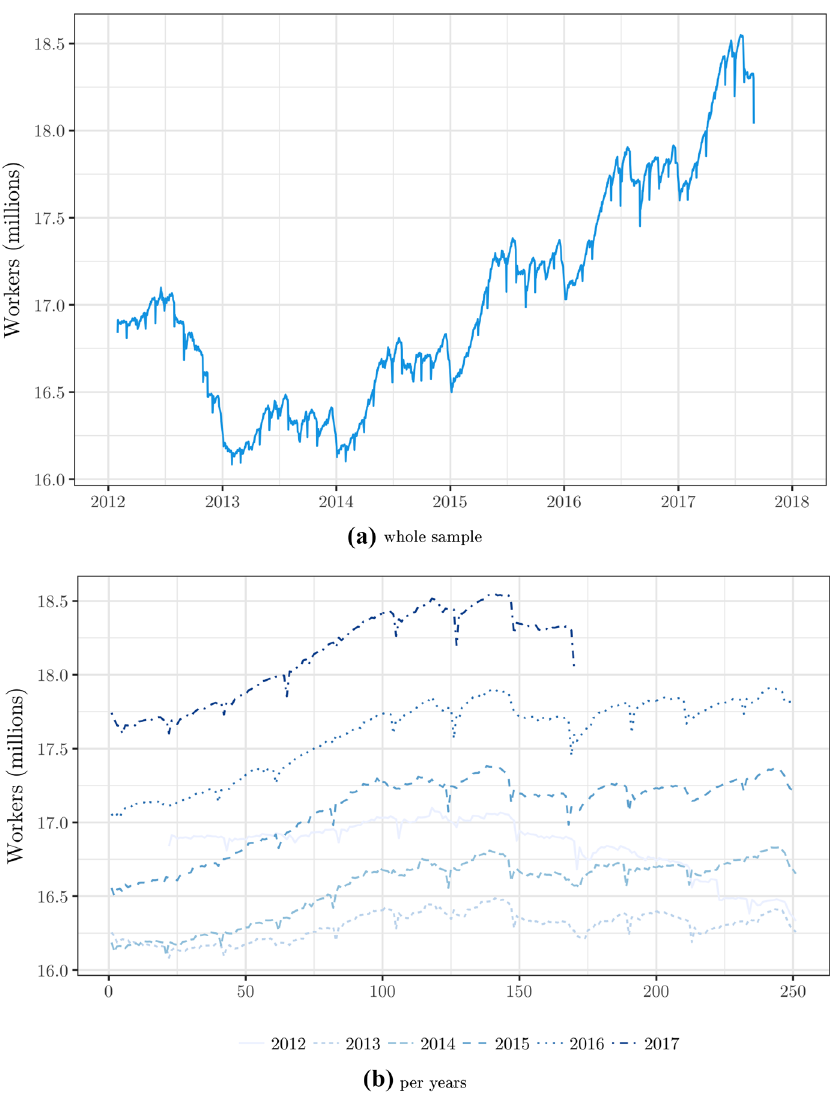
Fig. 1 Daily social security affiliates,